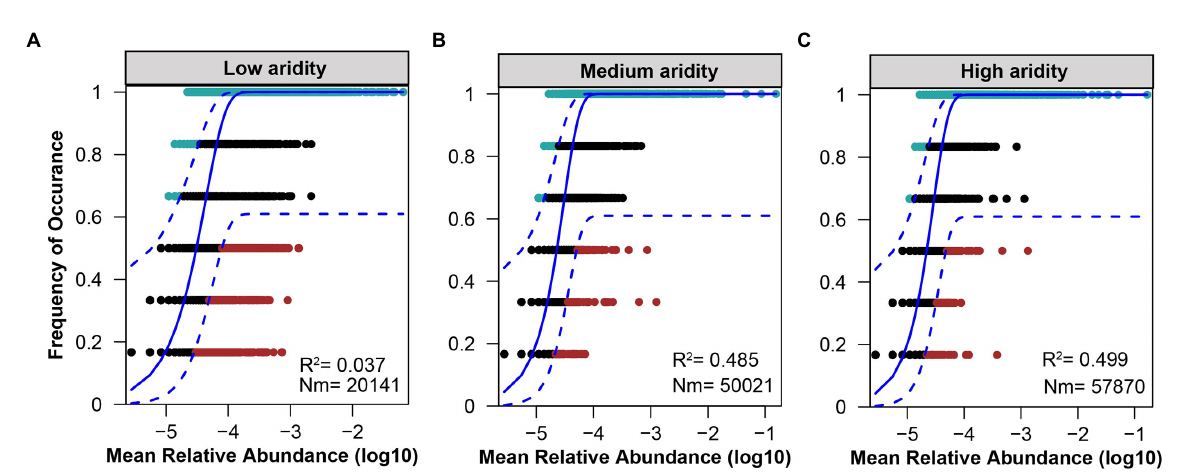
FIGURE 6 Fit of the neutral community model (NCM) of pqqC community in the low (A) , medium (B) , and high (C) aridity levels. The solid blue lines indicate the best ft to the neutral model and the dashed blue lines represent 95% confdence intervals around the model prediction. OTUs that occur more frequently than predicted by the model are shown in aquamarine, while those that occur less frequently than predicted are shown in red. OTUs that occur within prediction are shown in black. Rsqr indicates the goodness of ft to the neutral model. Nm indicates the metacommunity size times immigration.